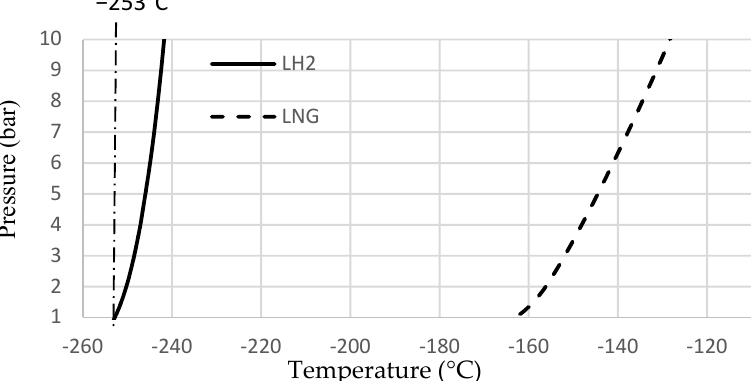
Figure 2. The figure shows the phase diagrams of liquefied hydrogen (LH 2 ) and liquefied natural gas (LNG) in the pressure range 1–10 bar as a function of temperature ( ◦ C). LNG data are based on [9] gas (LNG) in the pressure range 1–10 bar as a function of temperature (°C). LNG data are based on [9] and LH 2 data are based on [20]. and LH 2 data are based on